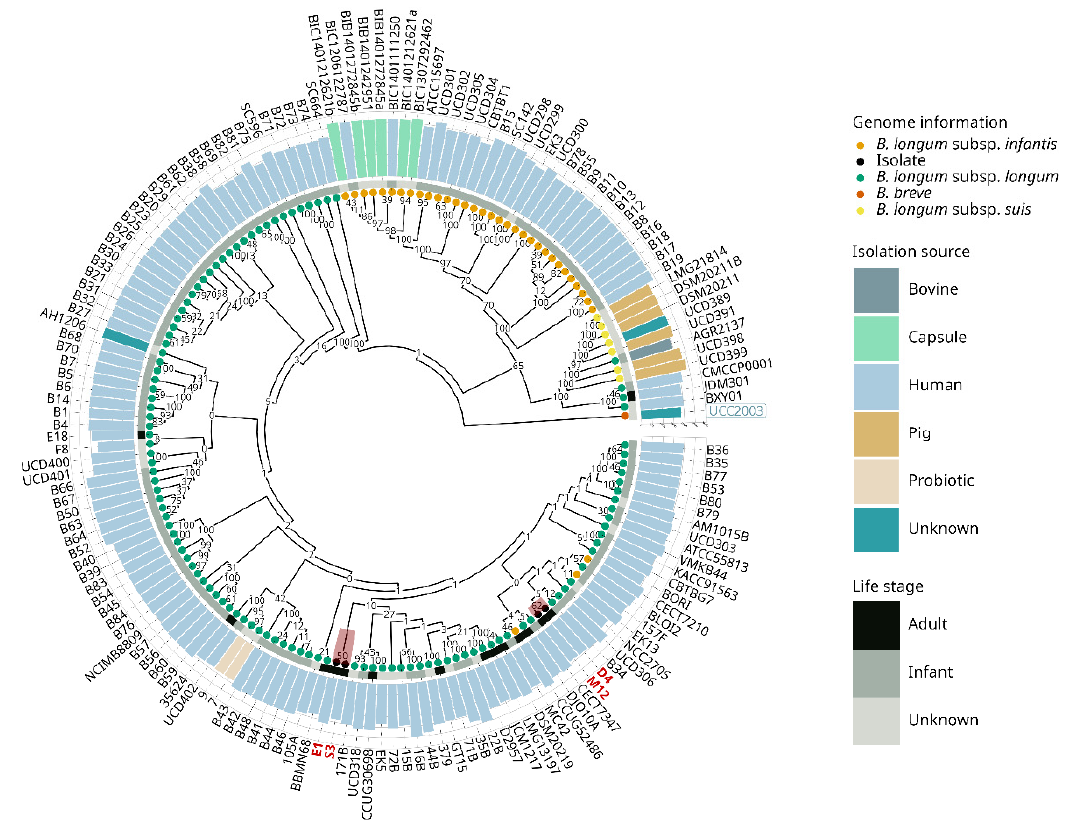
Figure 1. Phylogenetic tree of 158 B. longum subsp. longum strains showing metadata and bootstrap value between genomes. Colored bars and dots indicate genome information, isolation source, and life stage. Chilean strains are colored in red. Bifidobacterium breve UCC2003 was used as an outgroup.